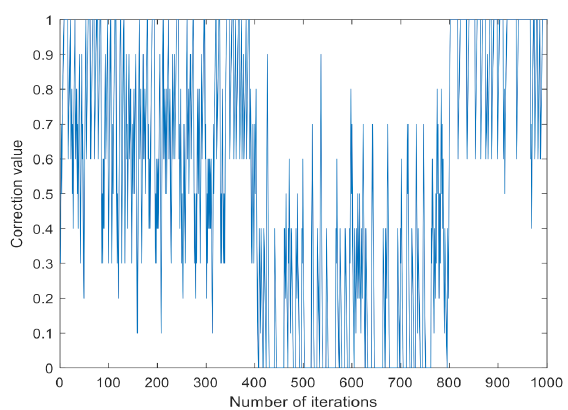
Figure 8. The change of 1000 recent reputation correction